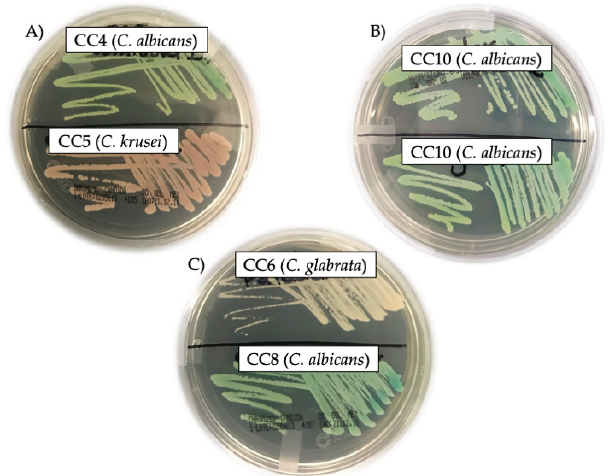
Figure 1. Representative photographs of the identification of the different species of Candida : ( A ) Upper half of Petri dish is CC4 ( C. albicans ), lower half of Petri dish is CC5 ( C. krusei ); ( B ) Upper and lower halves of Petri dish are CC10 ( C. albicans ); ( C ) Upper half is CC6 ( C. glabrata ), lower half is CC8 ( C. albicans